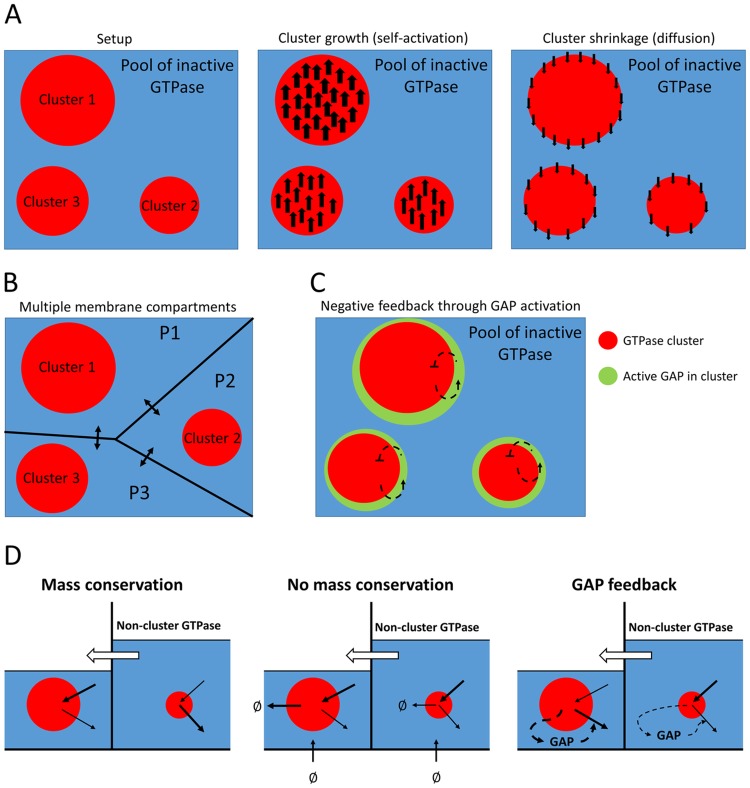
Principles of the simplified ODE models.A: The basic mass conserved ODE model starts with an arbitrary number of differently sized clusters (left, three are shown). Clusters compete for the inactive GTPase from a shared homogeneous pool. Activation and inactivation of membrane GTPase occur proportional to cluster size (middle). Additional loss of active GTPase (by diffusion from cluster to pool) occurs proportional to cluster circumference (right). B: An adaptation of the basic ODE model where each cluster has its own local pool of inactive GTPase (P1-P3) with fluxes connecting these local compartments (arrows). C: An adaptation of the basic ODE model with GAP feedback, where each cluster recruits GAP from a shared homogeneous pool at a rate proportional to the cluster size and GAPs (green) inactivate the GTPase in the cluster. D: Larger clusters more effectively deplete their local pool (blue), resulting in a concentration gradient and corresponding flux of GTPase from compartments with small clusters to compartments with large clusters. With mass conservation, this process continues until the small cluster is depleted. GTPase turnover effectively redistributes GTPases by removing more from larger clusters and providing new GTPase homogeneously, allowing the smallest cluster to compete in spite of this flux. At the same time, the larger cluster suffers from a smaller GTPase pool to recruit from. When GAP feedback is added, larger clusters recruit more GAP enhancing their own depletion, allowing smaller clusters to compete.